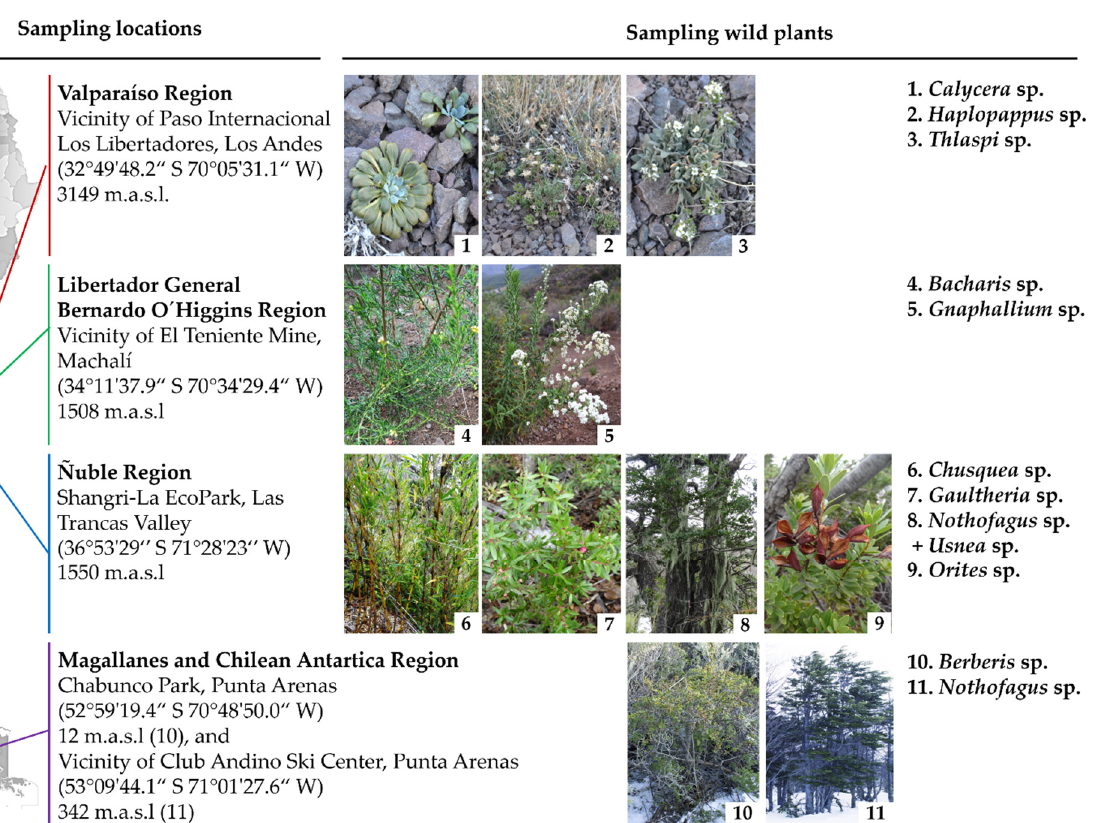
Figure 1. Location of sampling sites and sampled wild flora of Andean Mountains and Patagonia in Chile.